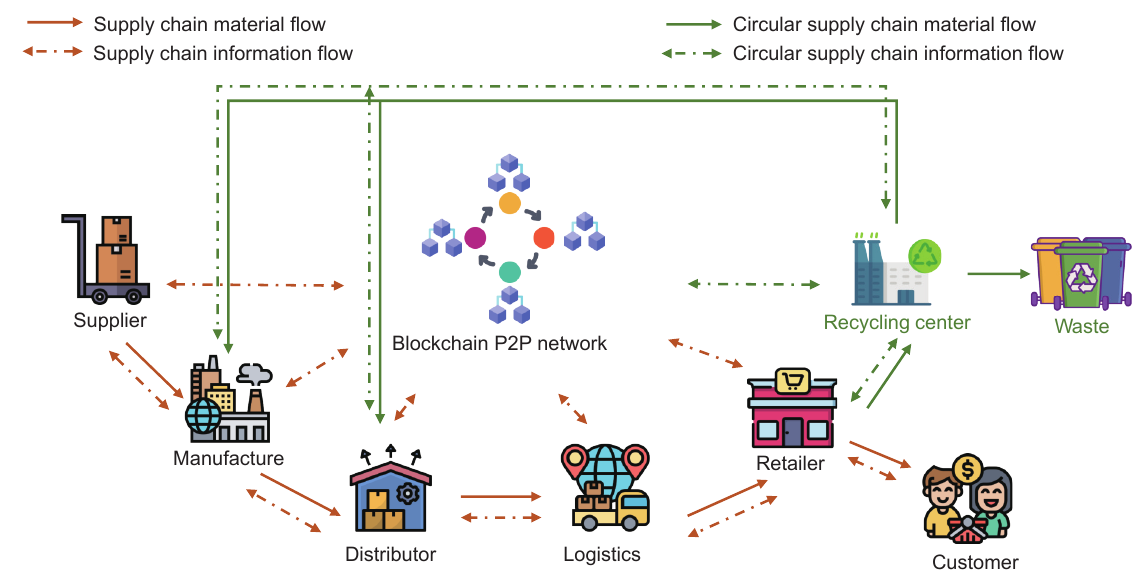
Fig. 9 Blockchain-enabled (circular) supply